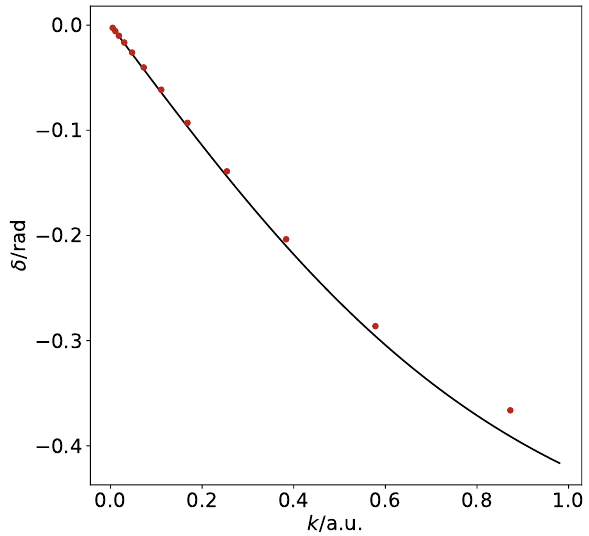
Figure 5. Phase shifts obtained by addition of three terms with α i (cid:54) = 1 to the basis. Black line: numerical solution of the radial Schrödinger equation in the static potential of the hydrogen atom included for